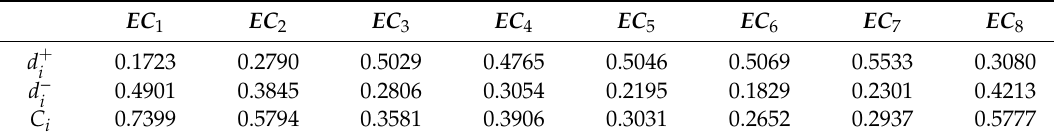
Table 10. The closeness degrees of ECs.